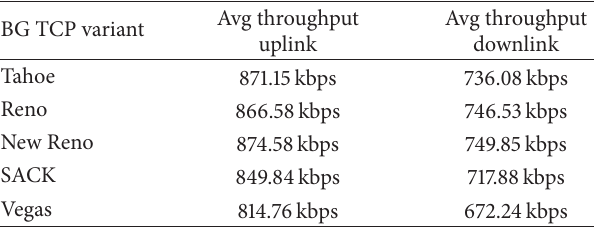
Table5:AveragethroughputobtainedbytheFTPbackgroundflows using different TCP